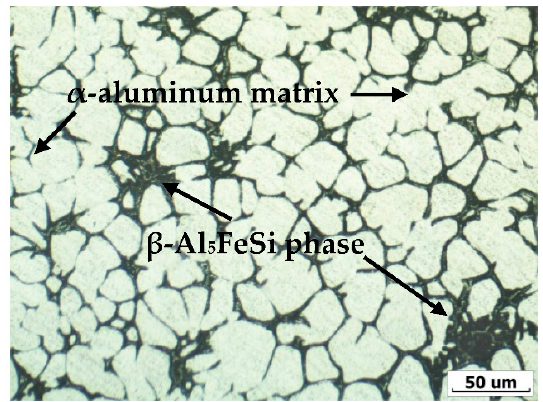
Table 2. Mechanical properties of the base SSM 6063 aluminum alloy used in this experiment [22].